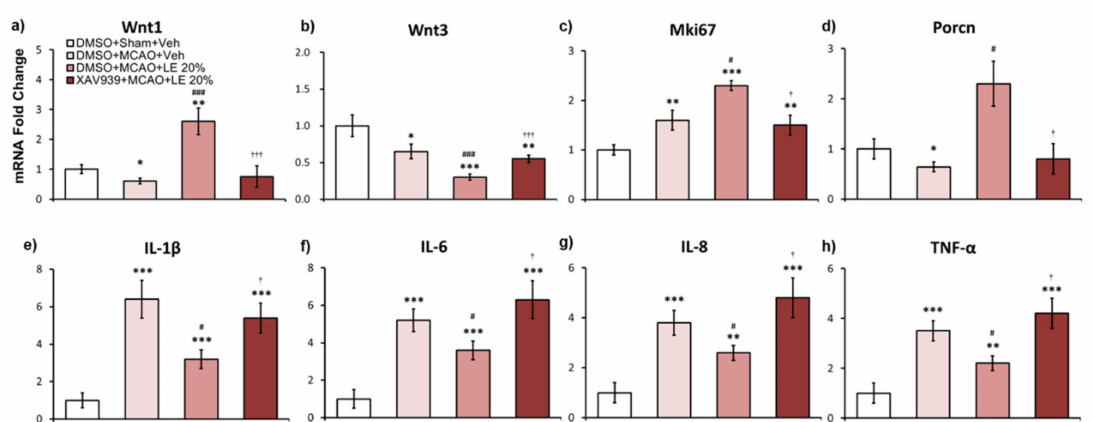
Figure 6. E ff ects of LE or vehicle on mRNA expression on the MCAO and reperfusion injury after the administration of DMSO or XAV939. ( a , b ) Wnt expressions in experimental groups. The Wnt1 mRNA expression of the DMSO + MCAO + Veh group was significantly decreased compared to the DMSO + Sham + Veh group. Significantly increased expression of Wnt1 was expressed Wnt1 decreased significantly in the XAV939 + MCAO + LE 20% group compared to the DMSO + MCAO + LE 20% group. There was no significant di ff erence in Wnt1 expression in the XAV939 + MCAO + LE 20% group compared to the DMSO + MCAO + Veh group. Wnt3 expressions were significantly lower in MCAO-injury groups compared to the DMSO + Sham + Veh group. Significantly decreased Wnt3 expressions were observed in the DMSO + MCAO + LE 20% group compared to the DMSO + MCAO + Veh and XAV939 + MCAO + LE 20% groups; ( c ) Mki67 expression was increased in all MCAO-injury groups compared to the DMSO + Sham + Veh group. Significant increase in Mki67 expression was observed in the DMSO + MCAO + LE 20% group compared to the DMSO + MCAO + Veh. The XAV939 + MCAO + LE 20% group had a significant decrease in Mki67 expression compared to the DMSO + MCAO + LE 20% group; ( d ) Porcn expression was significantly decreased in the DMSO + MCAO + Veh group compared to the DMSO + Sham + Veh group. Significant increase of Porcn was observed in the DMSO + MCAO + LE 20% group compared to the DMSO + MCAO + Veh. The XAV939 + MCAO + LE 20% group had a significant decrease in Porcn expression compared to the DMSO + MCAO + LE 20% group. There was no significant di ff erence in Porcn expression in the XAV939 + MCAO + LE 20% group compared to the DMSO + MCAO + Veh group; ( e – h ) The mRNA expression of inflammatory markers. MCAO injury groups expressed significantly increased levels of inflammatory markers compared to the DMSO + Sham + Veh group. Significantly decreased inflammatory expression levels were observed in the DMSO + MCAO + LE 20% group compared to DMSO + MCAO + Veh group. Significantly increased levels of inflammatory markers were observed in the XAV939 + MCAO + LE 20% group compared to the DMSO + MCAO + LE 20% group and DMSO + Sham + Veh group but there was no significant di ff erence compared to the DMSO + MCAO + Veh group. Data are presented as mean ± standard error of mean (SEM); n = 8 for each group; * p < 0.05, ** p < 0.01, *** p < 0.001 vs. DMSO + Sham + Veh, # p < 0.05, ### p < 0.001 vs. DMSO + MCAO + Veh, † p < 0.05, ††† p < 0.001 vs. DMSO + MCAO + LE 20%, one-way ANOVA followed by Tukey’s multiple comparison test. Wnt subfamily mRNA expressions are shown in Supplementary Materials